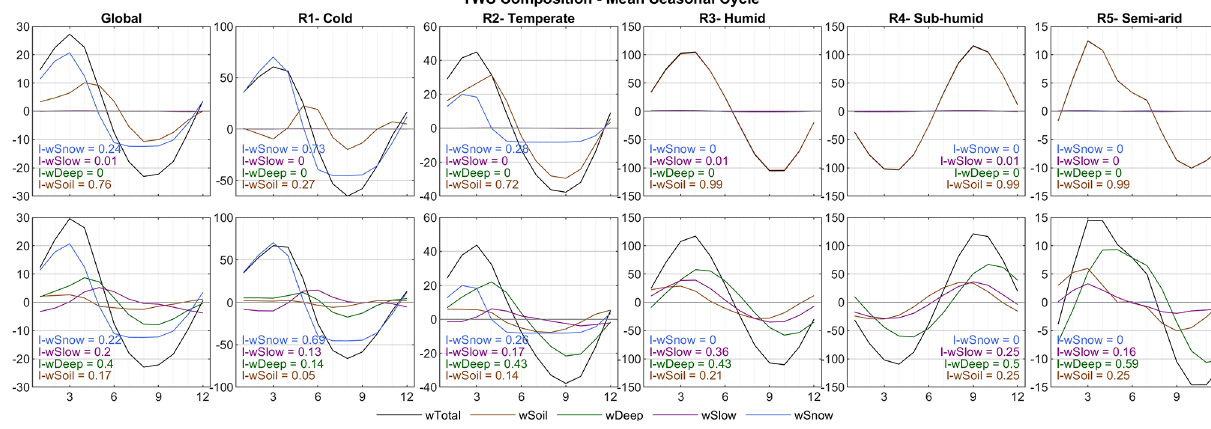
Figure 6. Global and regional average mean seasonal cycles of simulated total water storage and its components for B and VEG, including the regional impact index I for each